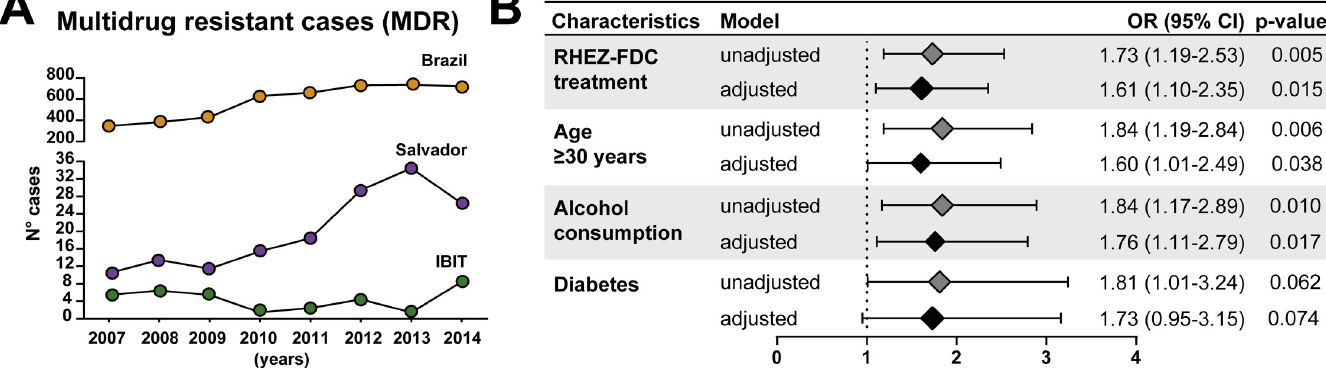
Fig 3. MDR-TB cases and crude and odds ratio for adverse drug reaction in tuberculosis patients. (A) Total number of MDR-TB cases shown per year in Brazil, Salvador and IBIT (B) A multivariable regression model adjusted for RHEZ-FDC treatment, age � 30 years, alcohol consumption and diabetes. The odds associated with the covariates used in the model adjustment are displayed in Table 3. OR = Odds ratio; CI = confidence intervals.